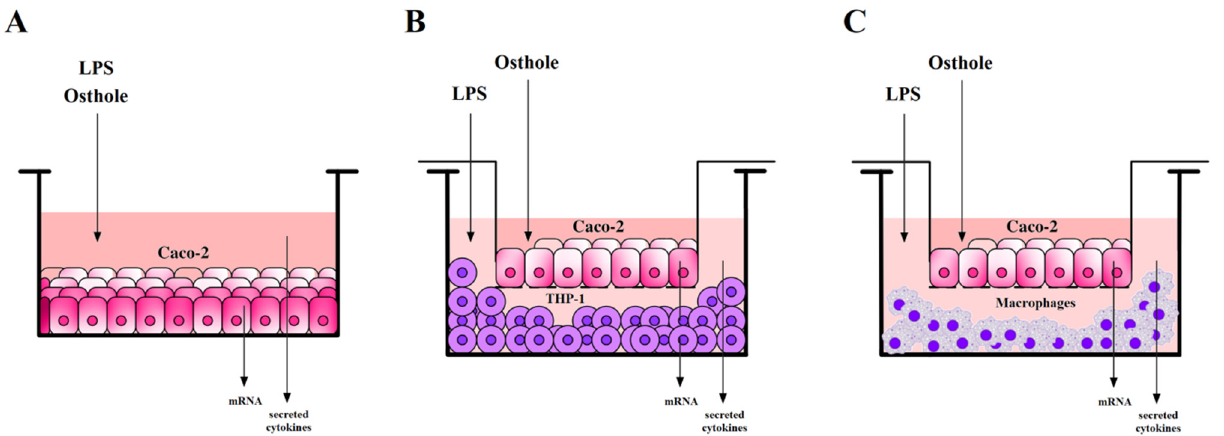
Figure 1. The scheme of experiments performed on Caco-2 cells ( A ) and Caco-2/THP-1 or Caco-2 macrophages co-culture models ( B , C ).